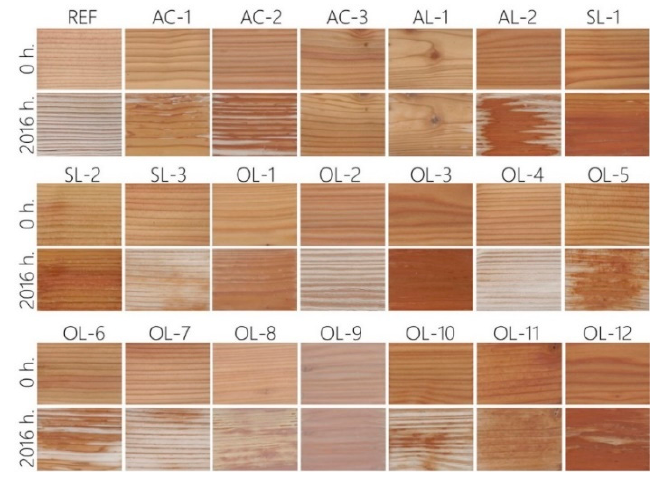
Figure 6. Visual evaluation of coating systems applied to European larch before (0 h) and after (2016 h) AW.